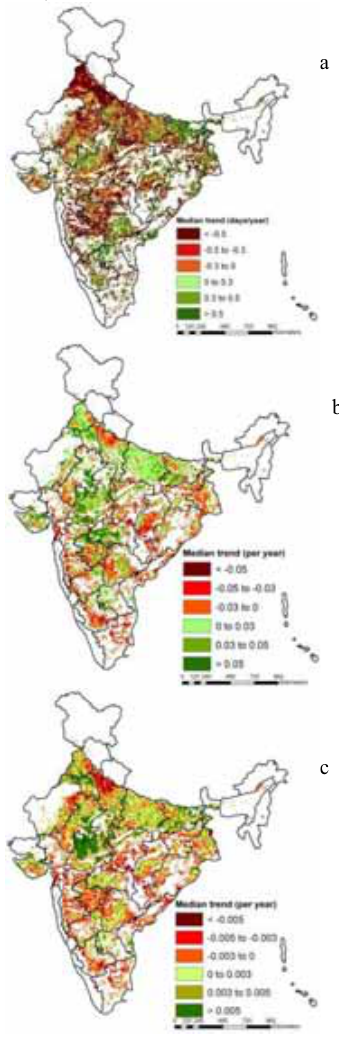
Fig. 3 Spatial pattern of median trend (Sen’s slope) of (a) SGS, (b), SiNDVI (c) AMP during kharif season using GIMMS NDVI data for the period of